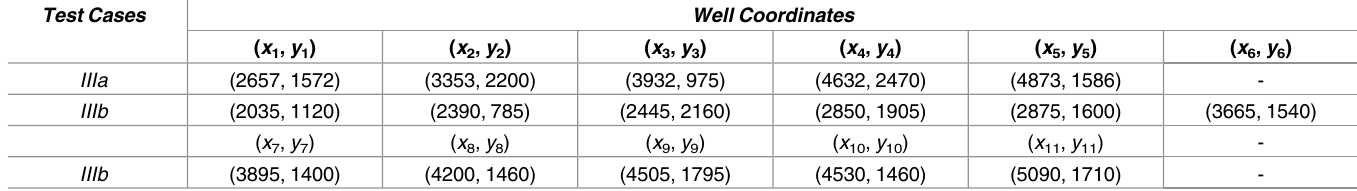
Table 4. Well Coordinates for the second group of simulation cases.